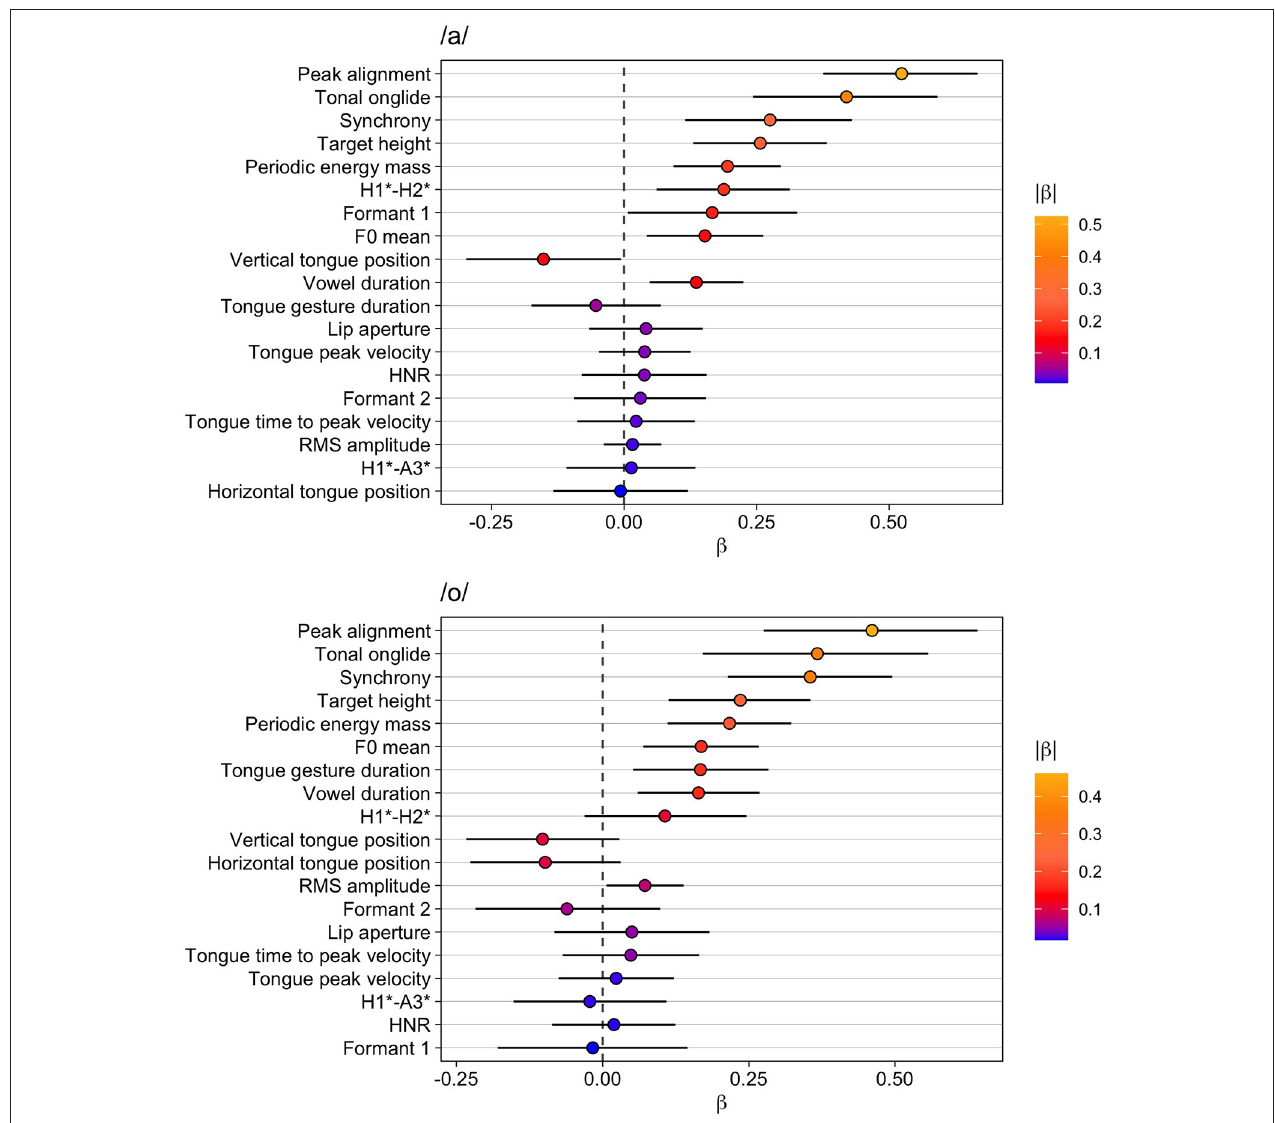
FIGURE 4 | Modeling results for broad vs narrow focus. Top: vowel /a/, bottom: vowel /o/. The whiskers indicate the 90% Credible